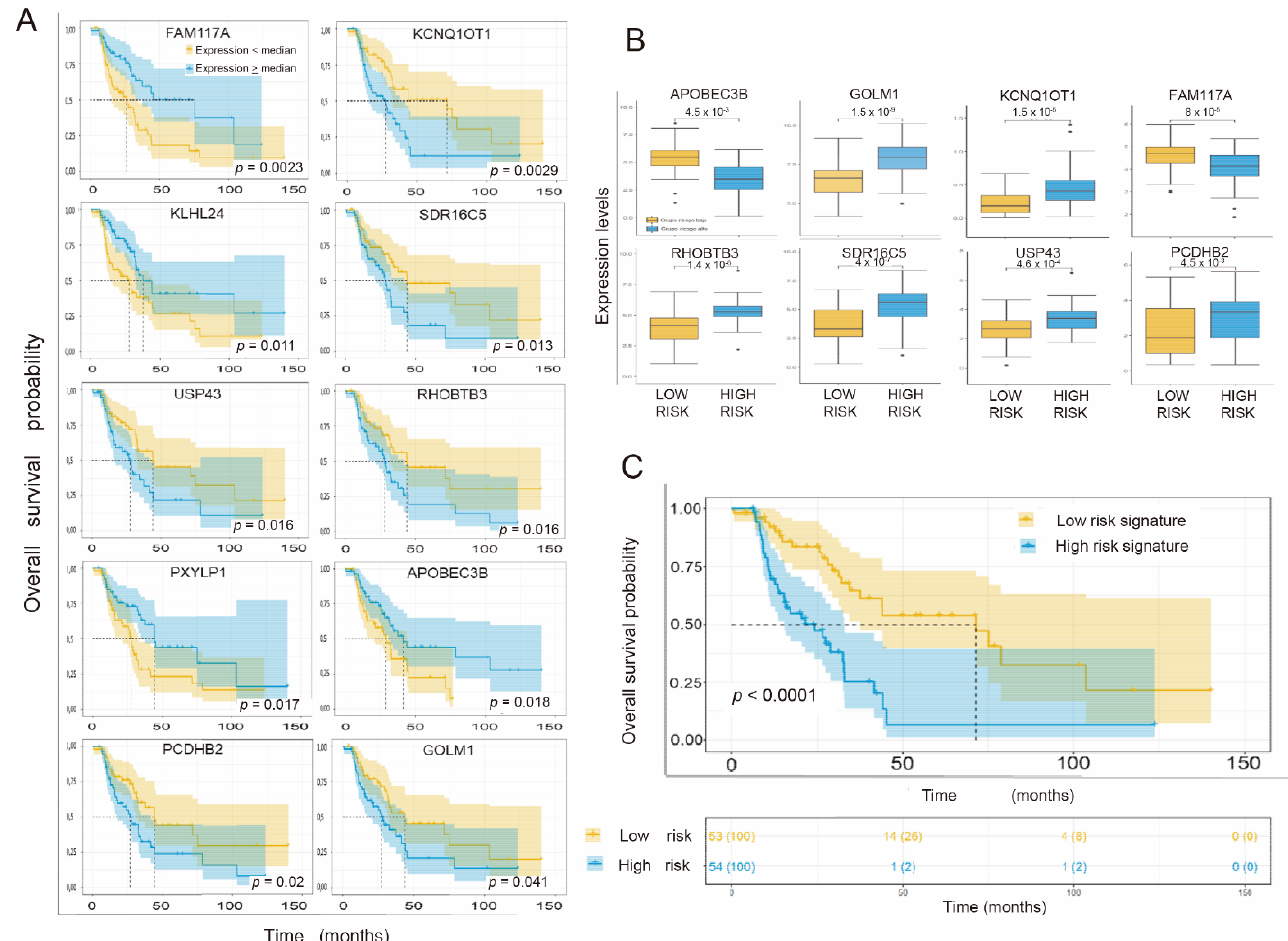
Figure 3. ( A ) Kaplan–Meier curves of the overall survival probability of the patients according to stratification by the expression levels of each individual gene. The information regarding the 10 genes of interest (see text) is ordered by level of statistical significance ( p -value). The ordinate axis represents the probability of survival (0–1), and the abscissa axis represents the overall survival in months. Yellow represents patients whose expression level of the gene in question was lower than the median expression of the gene, and blue represents patients with expression levels equal to or greater than the median expression of the gene in question. ( B ). Box plot showing the expression levels (logTPM) (normalized) of each gene that makes up the signature based on the prognostic group (low and high risk). ( C ). Kaplan–Meier curves in which the overall survival probability of the patients is represented according to their grouping according to the established cutoff point, which corresponds to the median of the risk scores of each patient in the cohort, separating the latter into two groups (high or low risk, depending on whether their individual risk score is higher than/equal to or lower than the cutoff point, respectively). Likewise, the number of patients at risk in each group is represented according to the established time intervals. *, p < 0.05; **, p < 0.01. The expression of the gene in each group is shown by the box diagram in Figure